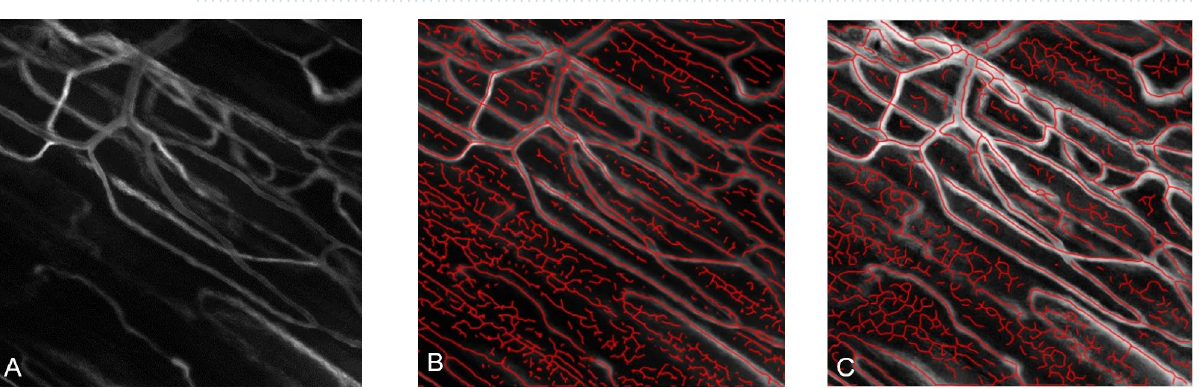
Figure 6. Overlay SAD and SUDCS. (A) Original SAD image (FOV: 400 × 400 µm). (B) An original SAD image with overlaid SUDCS vessel structure results (red lines). (C) Augmented SAD image after removing motion artifacts and CLAHE filtering overlaid with the modified SUDCS, a binary mapping (red line) is superimposed on the vessel structure. Note the false-positive segment structures, which will be removed in the 2nd step of the 3D-CNN 45,46